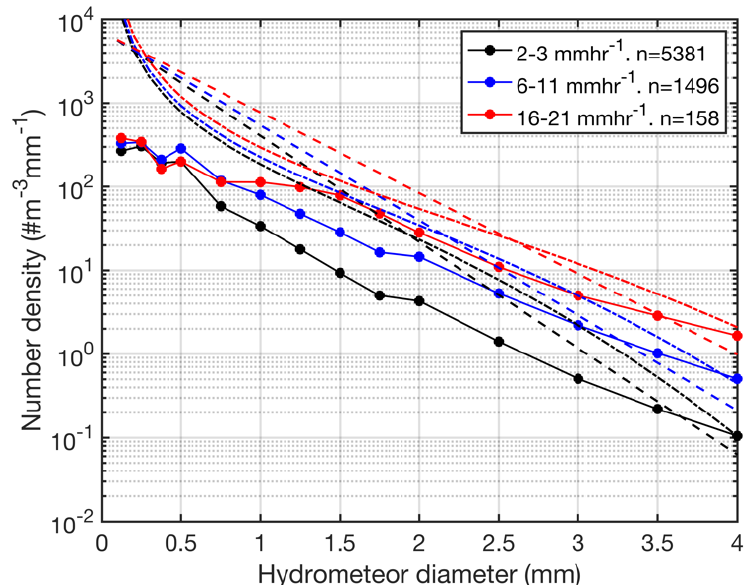
Figure 6. Mean droplet size distributions from the Thies LPM at WAO (coastal UK) conditionally sampled for liquid only precipitation and three different RR; 2 – 3 mmhr – 1 , 6 – 11 mmhr – 1 and 16 – 21 mmhr – 1 . The legend shows the number of 1 min periods (n) used to compute these mean DSD for each class of RR. Additionally, shown are the estimates of the DSD derived using Marshall-Palmer (dashed lines) and Best approximations (dashed-dot lines) for the mid-point of each RR range.